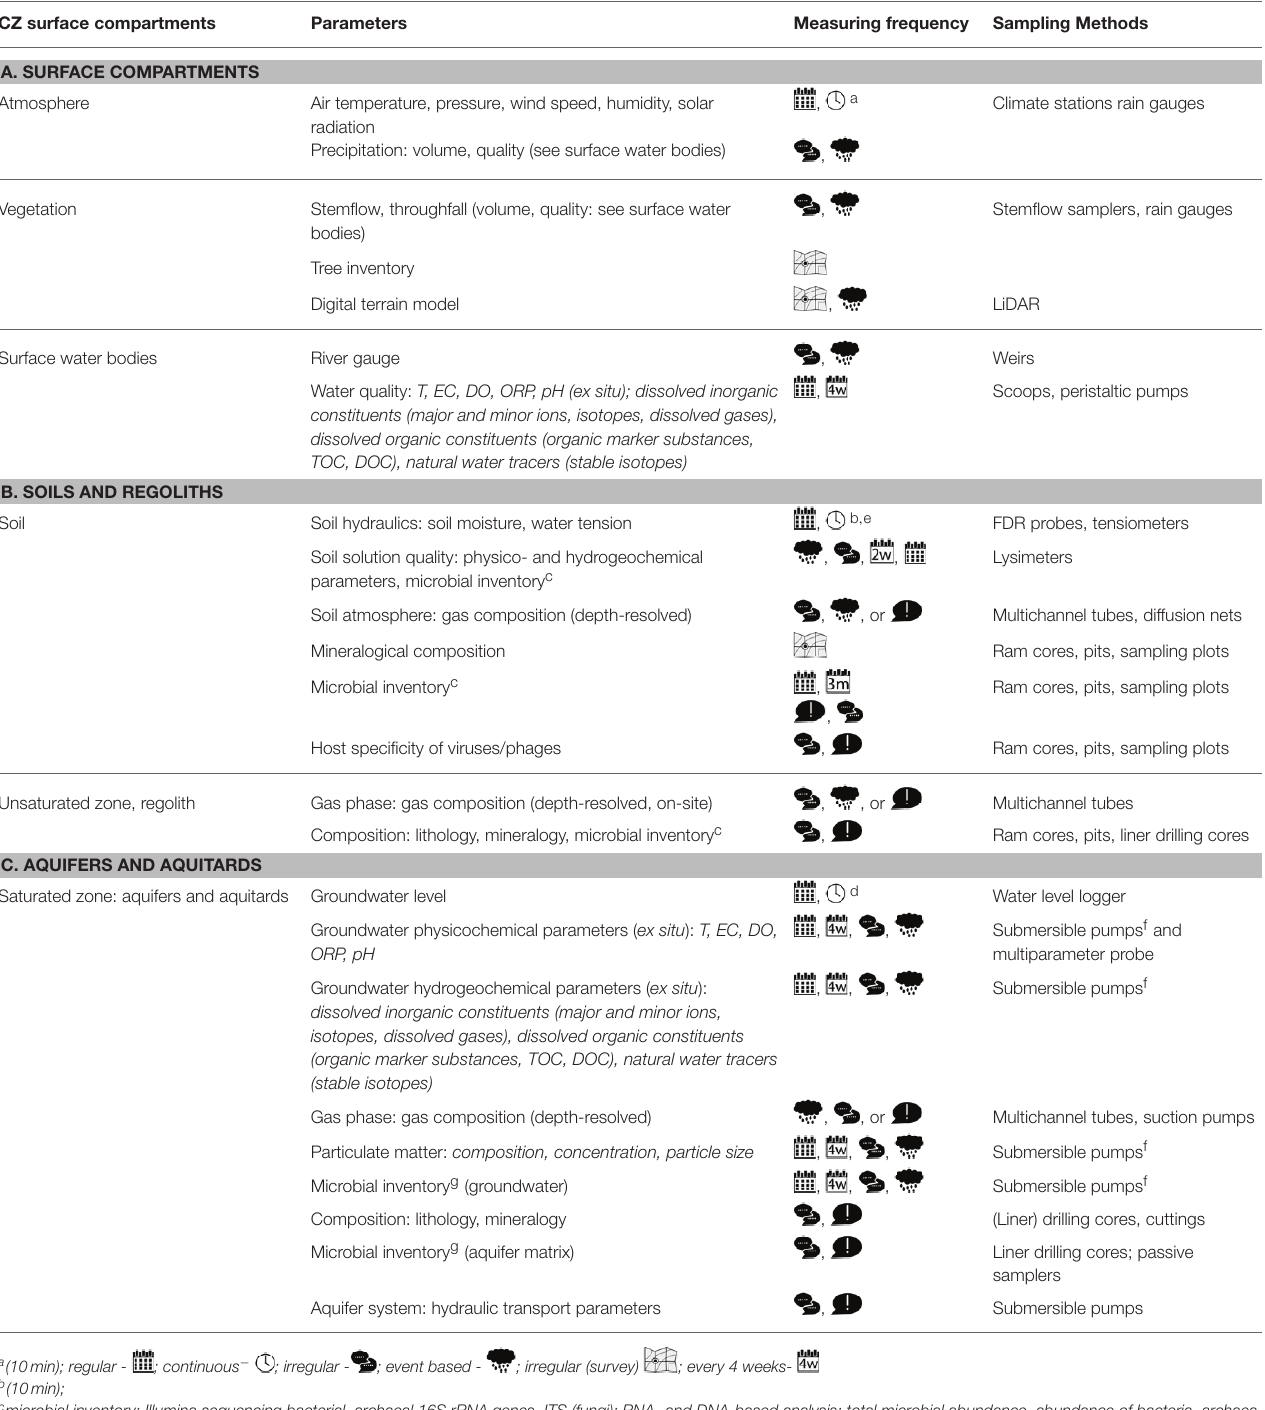
TABLE 1 | Measuring program in the Hainich